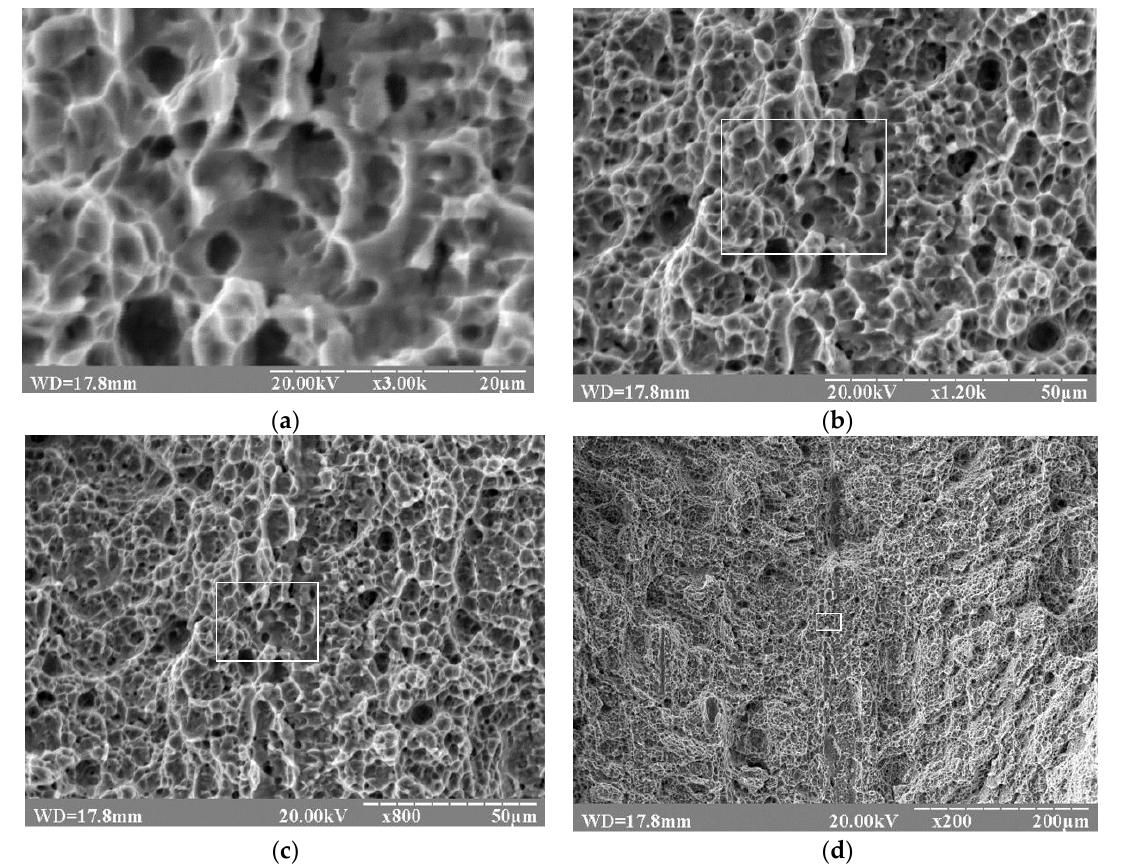
Figure 2. SEM images of fracture surfaces of specimens from the VT23M alloy at various magnifications: ( a )—x3000; ( b )—x1200; ( c )—x800; ( d )—x200; a frame on the fracture surface provides a link to the location of the fragment of the fracture surface shown in Figure 2а.